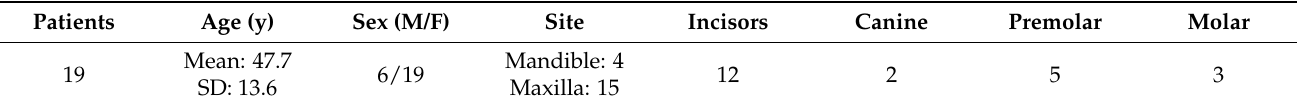
Table 1. Demographic